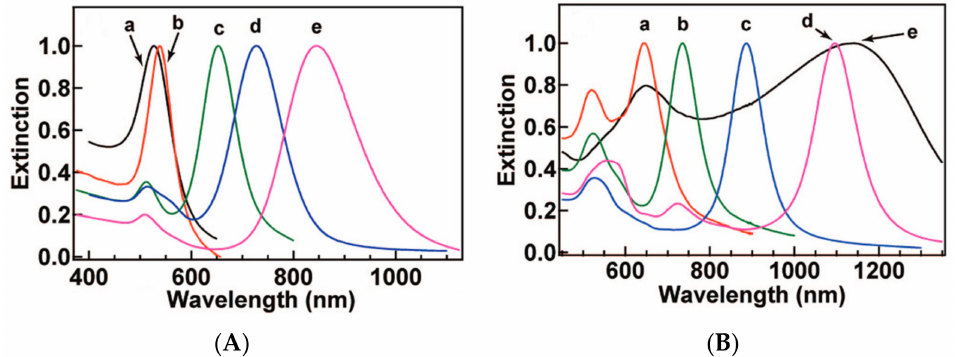
Figure 4. Wavelength dependency of the LSPR band on NP shape and size ( A ) Spectra a: nanospheres, b: nanocubes, and c–e: nanorods with aspect ratios from 2.4 to 4.6. ( B ) Spectra a–d: nanobipyramids with aspect ratios from 1.5 to 4.7, e: nanobranches. Reproduced with permission from